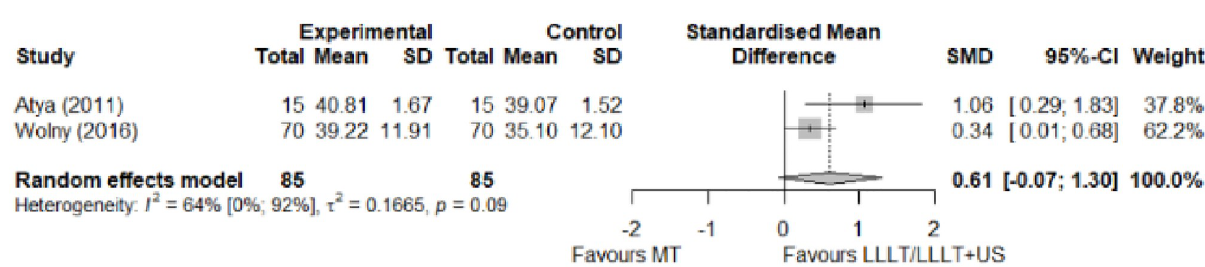
Fig 18. Analysis—Electrophysical modalities versus manual therapy (sensory velocity).